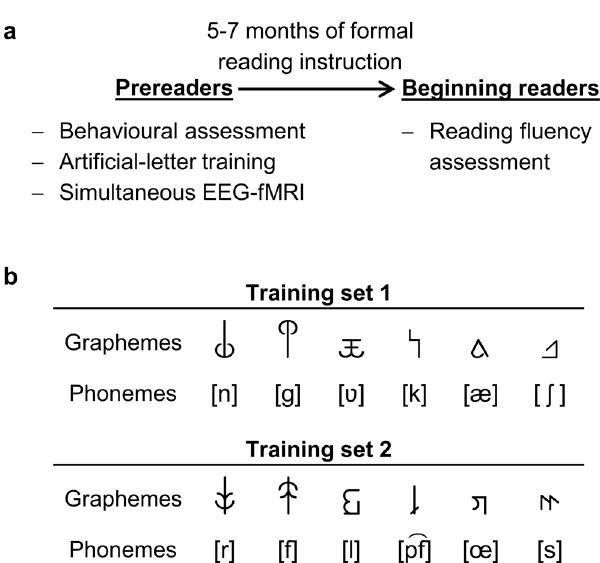
Figure 1. Study design and experimental stimuli. ( a ) In a longitudinal study design, participants were tested before and after the onset of formal reading instruction at school. ( b ) Stimulus sets used in the artificial-letter training and the implicit audiovisual target detection task. Participants were randomly assigned to learn one of two matched sets of grapheme–phoneme correspondences. In a simultaneous EEG-fMRI session, correct (congruent condition) and incorrect (incongruent condition) pairs of trained graphemes and phonemes were presented to the participants. Phonemes are presented in phonetic notation; phonemic notation from left to right for training set 1 is /n/, /g/, /w/, /k/, /ä/, and /sch/ and for training set 2 /r/, /f/, /l/, /pf/, /ö/, and